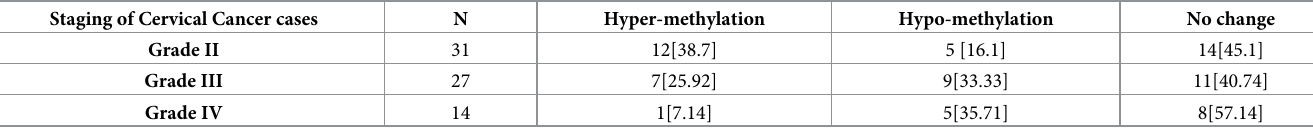
Table 3. Methylation status in affected area compared to non-neoplastic control area in HPV positive cases. Staging of Cervical Cancer cases